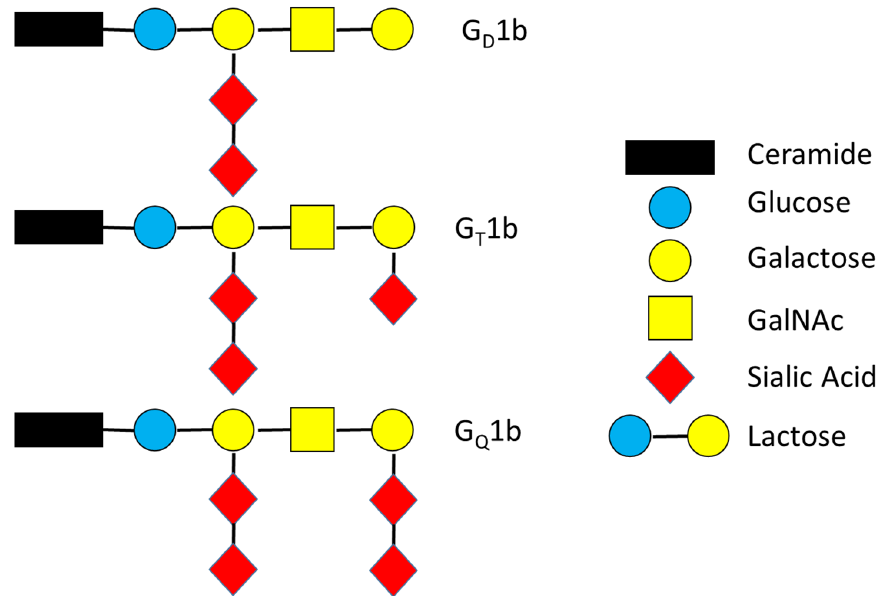
Figure 3. Structures of gangliosides G1b.